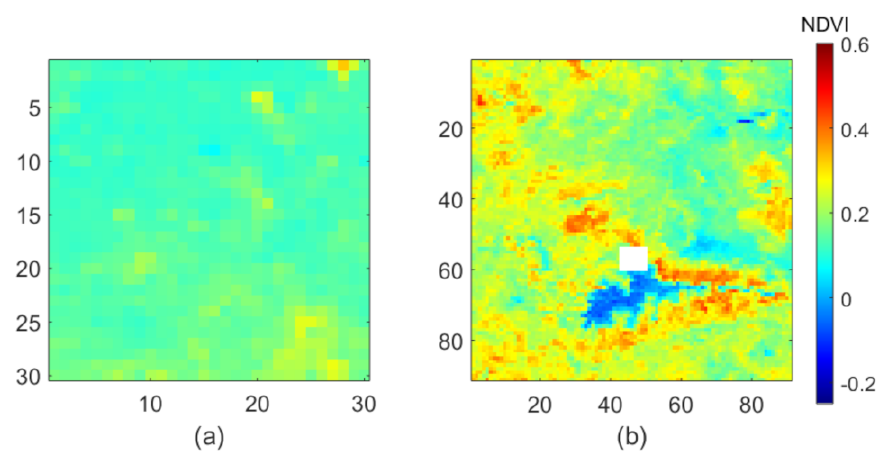
Figure 2. Enlarged study regions as indicated by the black rectangles in Figure 1 referring to 23 January. ( a ) shows study region 1, and ( b ) shows study region 2. Note that the latter is three times larger than the former. Study region 2 contains natural missing data (white), unlike study region 1. Table 1. An overview of all data sets used in this study. The resulting data sets will be referred to by the corresponding aliases. Alias Description Dimension Constructed by repeating a single time frame from 30 × 30 × 30 SIM1 study region 1 with no missing data. Missing data were added artificially. Used for model evaluation. Constructed by adding noise to SIM1. Missing data SIM2 30 × 30 × 30 were added artificially. Used for model evaluation. All time frames from study region 1 with no missing SPAIN1 data. Missing data were added artificially. Used for 30 × 30 × 54 model evaluation. Study region 2 with natural missing data. No ground SPAIN2 truth data available. Used to demonstrate the 90 × 90 × performance of the models visually.